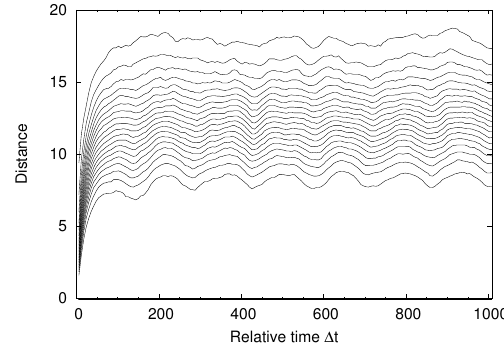
Figure 2. The space–time separation plot for the time series for Fig. 2. The Space time separation plot for the time series for m =14 m = 14 and τ = 85. Each point in the plot represents a pair of points and τ =85 . Each point in the plot represents a pair of points on the on the trajectory with their relative separation in time along the hor- trajectory with their relative separation in time along the horizontal axis and separation in space along the vertical axis. The diurnal izontal axis and separation in space along the vertical axis. The di- variations are evident in this figure. urnal variations are evident in this Fig. 3. (a) The autocorrelation function of wind speed data. (b) Mu- tual information of the wind speed data as a function of delay ( τ ). deterministic character of wind speed has to be ascertained on a per location basis due to the highly uncertain nature of wind from location to location, we will now carry out a 160 brief analysis of the data, referring the reader to Sreelekshmi et al. (2012) for the finer details of the features of chaotic sys- tems and of the methods applied. The wind speed prediction schemes to be described later in coming sections are based on the results of this analysis. 165